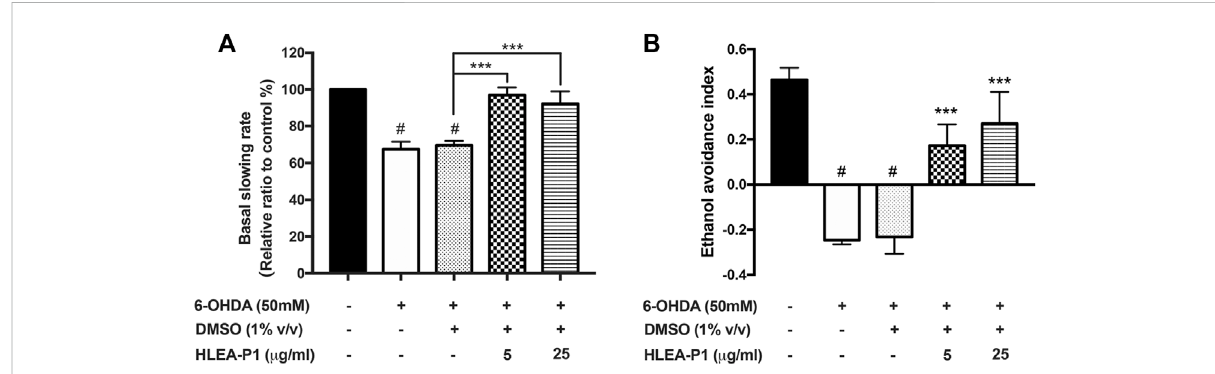
FIGURE 2 Effect of HLEA-P1 on dopamine dependent behaviors in 6-OHDA-induced C. elegans PD model. (A) Graphical representation for relative basal slowing rate. The data are presented as mean ± SEM (with three independent replicates, n = 30 number of animals per replicate). (B) Graphical representation for ethanol avoidance index. The data are presented as mean ± SEM (three independent replicates, n ≥ 50 number of animals per replicate). The hash (#) indicates a signi fi cant difference between normal and 6-OHDA-induced worms ( p < .05). The asterisk (*) indicates signi fi cant differences between untreated group (6-OHDA/DMSO) and HLEA-P1-treated groups, *** p < .001.